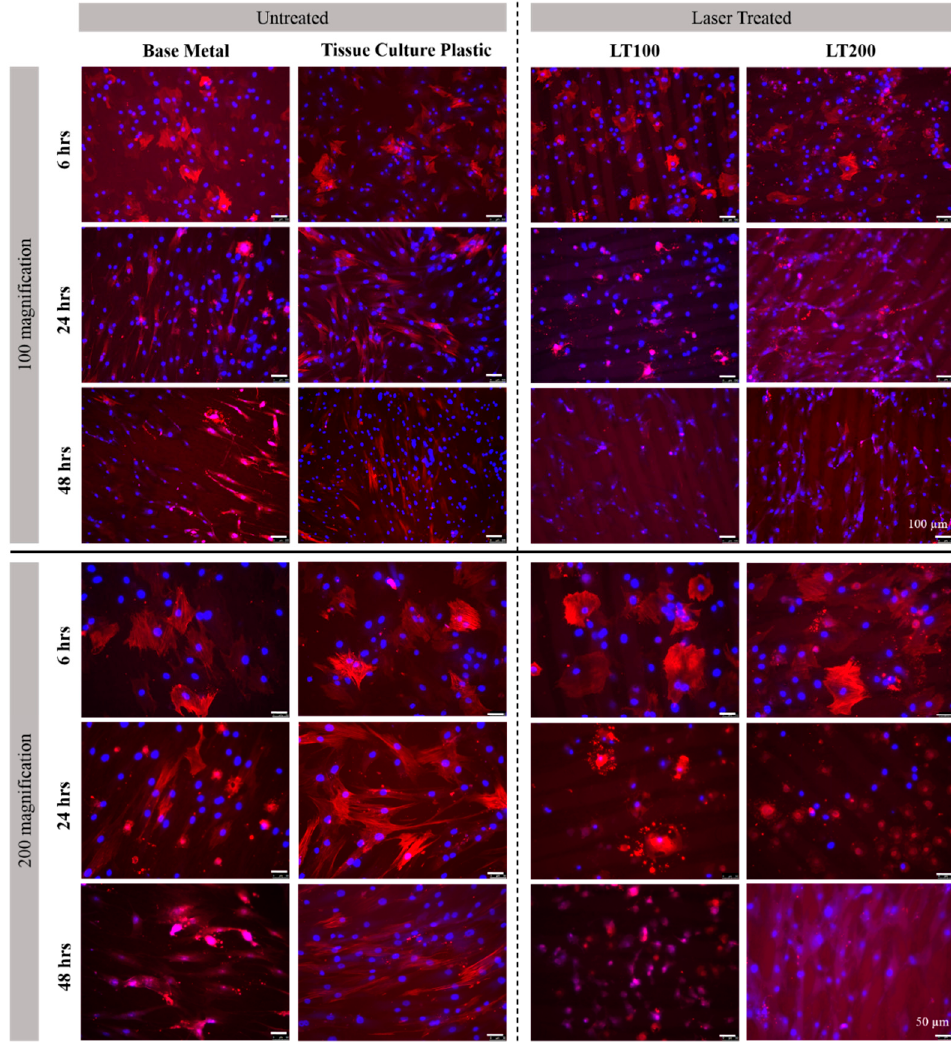
Figure 5. Laser surface treatment at high scanning speeds can be used to encourage cell spreading. Merged fluorescence images of mesenchymal stem cells (MSCs) stained at 6, 24 and 48 h at 100 × (top) and 200 × (bottom) magnification on untreated and laser treated surfaces. Red = α SMA actin fibres; blue = DAPI nuclei stain. Scale bar = 100 µ m (top) and 50 µ m (bottom). Images are representative of cell coverage on the entire surface.